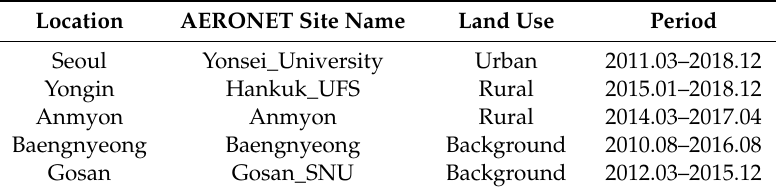
Figure 1. Locations of five selected AErosol RObotic NETwork (AERONET) sites in Korea. The background map was obtained from © Google Maps. Table 1. Information on five selected AERONET sites in